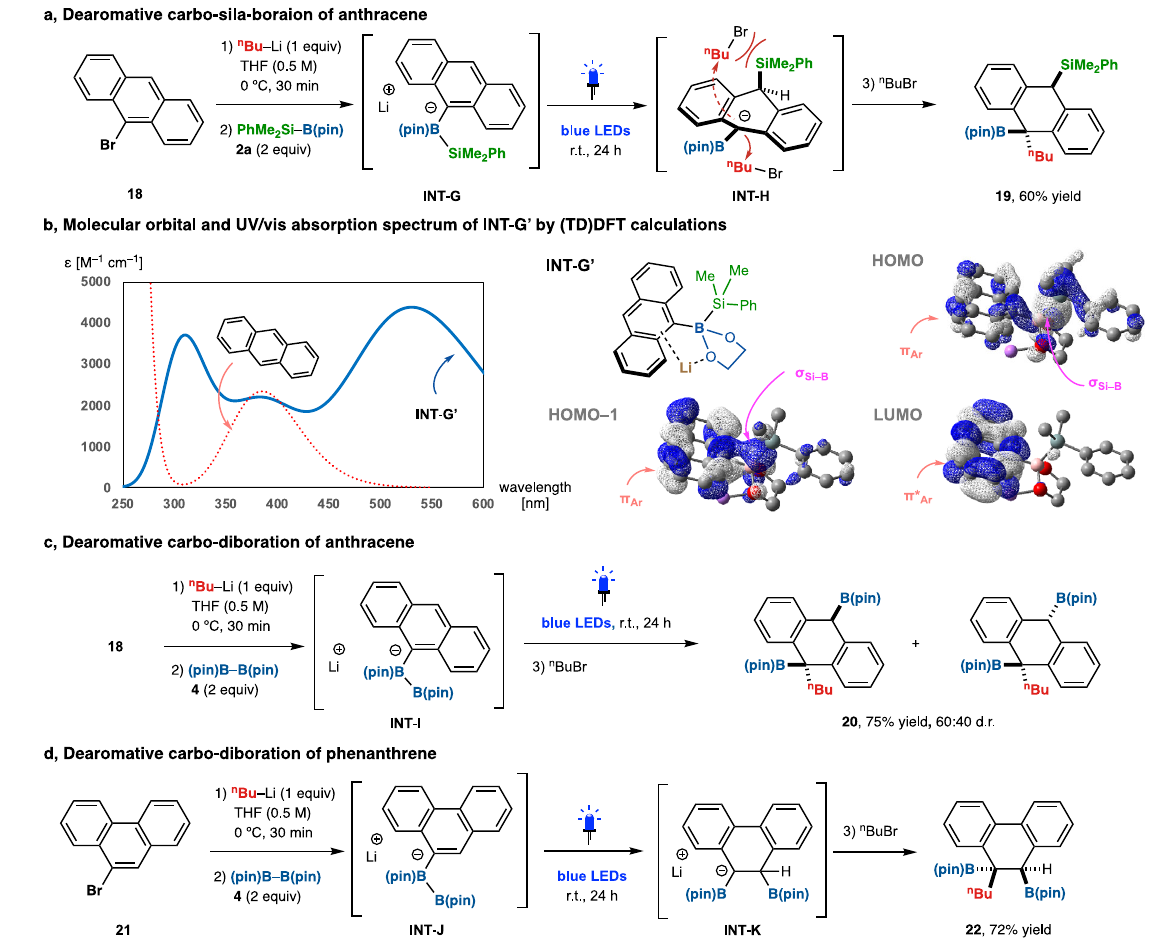
Fig. 7 | Dearomative triple elementalization of anthracene and phenanthrene. a Synthesis of carbo-sila-borated dihydroanthracene. b Molecular orbital and UV/ vis absorption spectrum of INT-G ’ by (TD)DFT calculations at the B3LYP/6-31+G* level of theory. c Synthesis of carbo-diborated dihydroanthracene. d Synthesis of